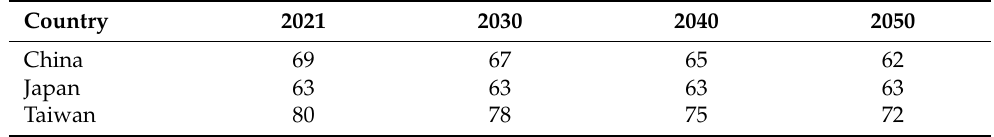
Table 2. Weighted average fuel CO 2 emission factors for the textile industry (kg CO 2 /GJ) (calculated based on [16]).